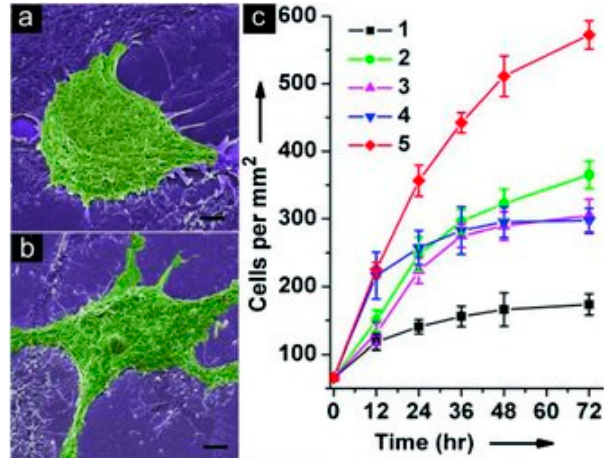
Figure 6. SEM images of MCF-7 cells cultured (12 h) on ( a ) ITO/(AP) 10 and ( b ) ITO/(graphene-AP) 10 . The scale bar is 5 µm for ( a ) and ( b ). ( c ) Proliferation curves of cells cultured on fi lms with different